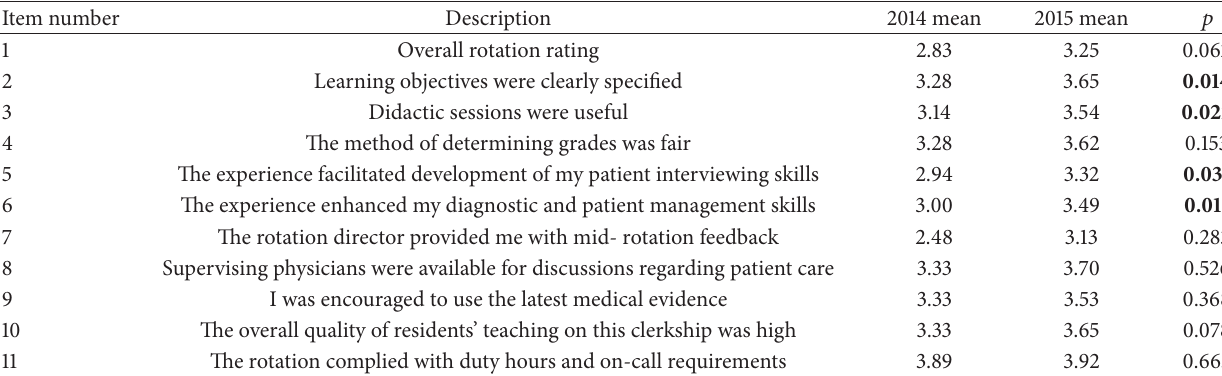
Figure 1: Mann–Whitney 𝑈 test results for 2014 versus 2015. Group A = 2014; Group B = 2015. Table 2: Medical student-reported first semester rotation performance, 2014 versus